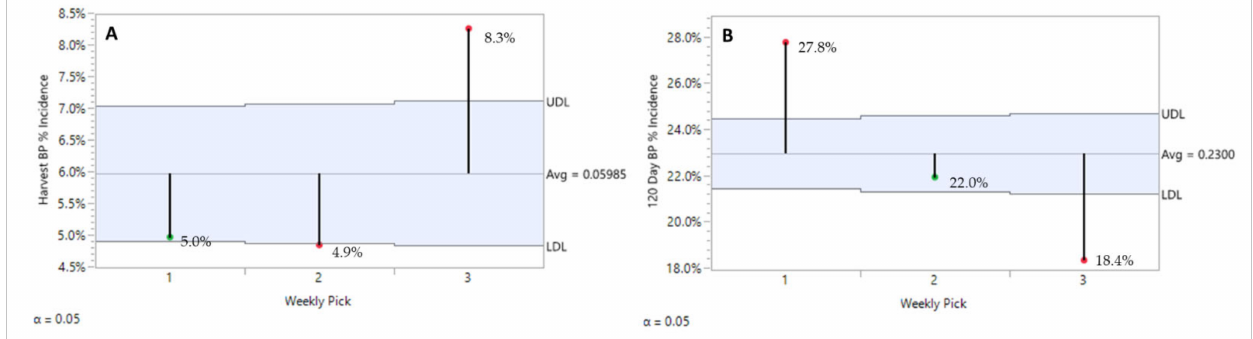
Figure 5. Pick timing effect on ‘Honeycrisp’ bitter pit incidence at harvest ( A ) and after 120 days of refrigerated storage ( B ) with all rootstocks and years combined. JMP Fit XY Platform, Analysis of Means of Proportions of the binomial dataset, alpha = 0.05.